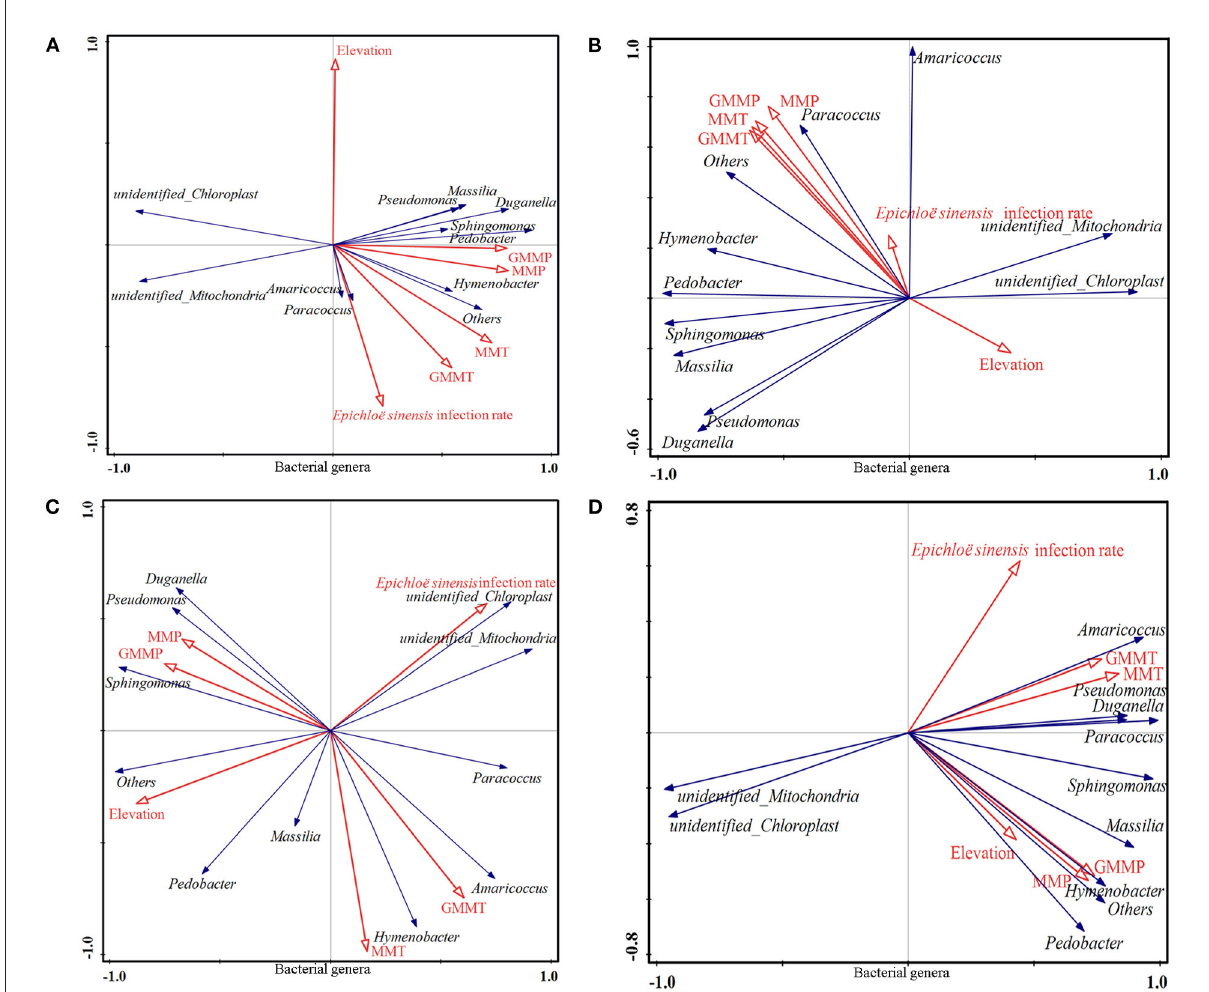
FIGURE7 Effect of environmental factors on bacterial genera. (A) on overall elevation (2,589–5,197m). (B) on high elevation (2,589–3,000m); (C) on medium-high elevation (3,000–4,500m); (D) and on extremely high elevation (4,500–5,197m). The microbial parameters (expressed as response variables in the RDA) were presented as black line vectors, and the environmental factors (explanatory variables) were presented as red line vectors. MMT, monthly mean temperature; MMP, monthly mean precipitation; GMMT, growing monthly mean temperature; GMMP, growing monthly mean